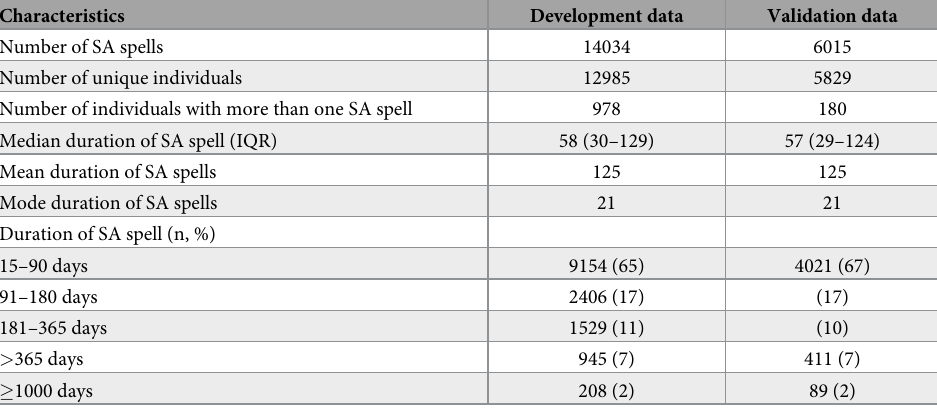
Table 1. Descriptive statistics of all the 14034 included incident sickness absence (SA) spells due to